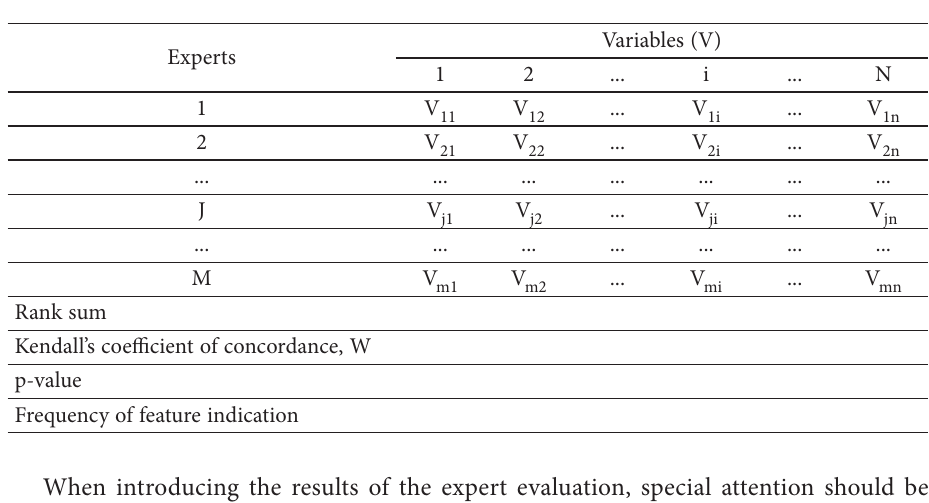
Table 3. Matrix of the expert evaluation results on digital shadow economy concept, features and channels Experts